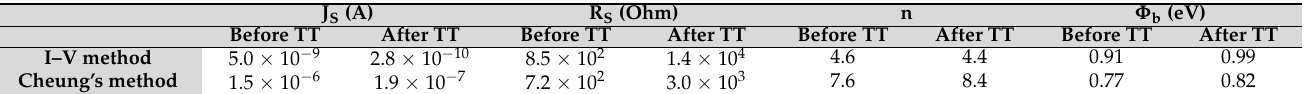
Table 3. NiO:N/m-TiO 2 /c-TiO 2 /FTO diode characteristics before and after thermal treatment (TT): saturation current density (J S ), barrier height ( Φ b ), ideality factor (n) and series resistance (R S ), after applying I–V and Cheung’s